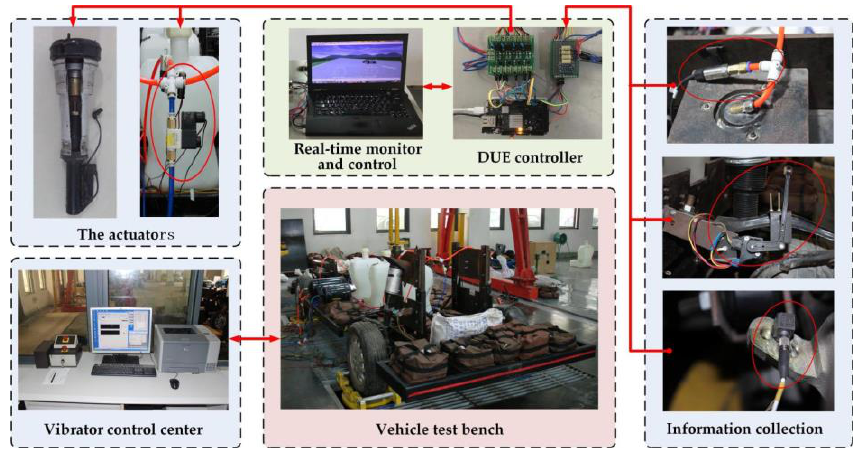
Figure 20. Structure of the test bench.